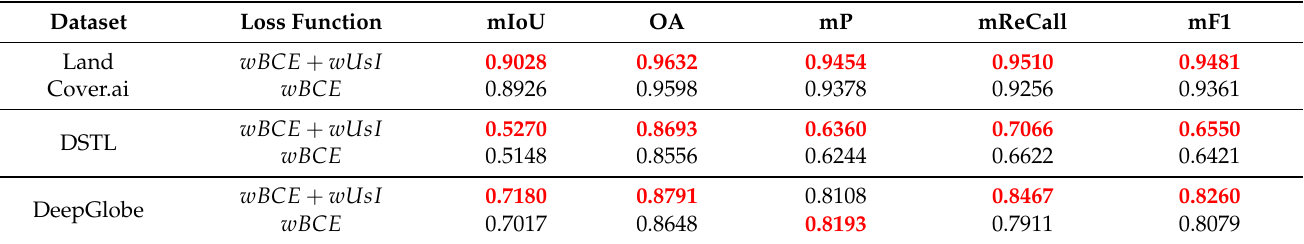
Table 7. The quantitative results of loss function ablation experiments on the three datasets. (The red color indicates the better performance).